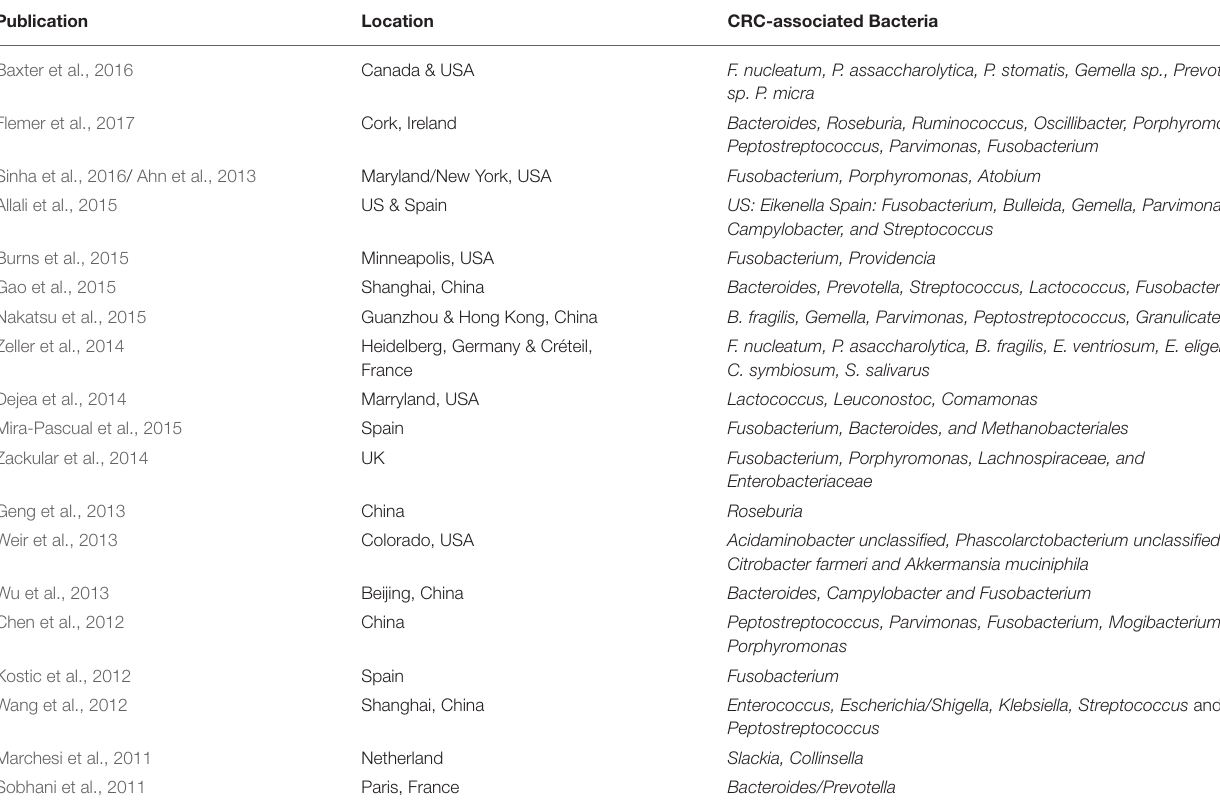
TABLE 1 | CRC-associated bacteria of different geographical